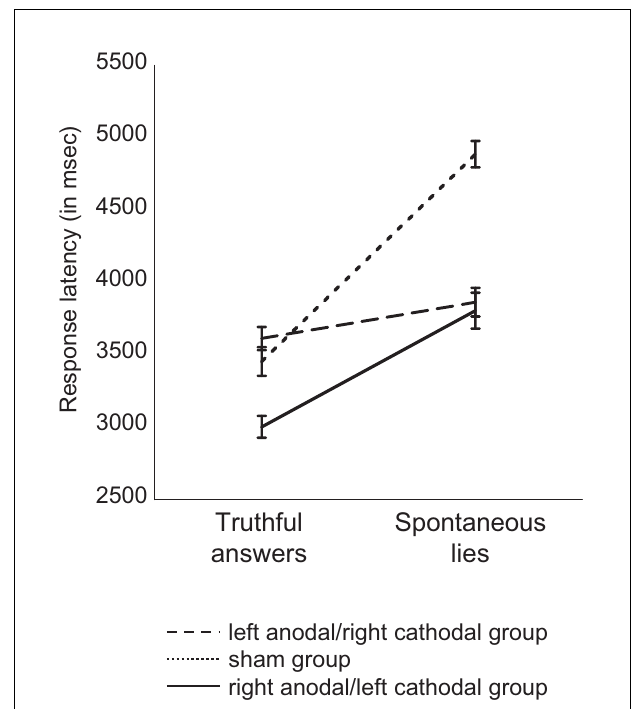
FIGURE 3 |Averaged response latency of truthful answers and memorized lies for each group of participants inTask 2. Participants who received active DLPFC stimulation were faster at retrieving memorized lies as illustrated by smaller difference in response latency between truthful and memorized lies (right anodal/left cathodal DLPFC stimulation: difference of 10ms; left anodal/right cathodal DLPFC stimulation: difference of 6ms) than the sham groups (difference of 166ms). Error bars represent SEM.